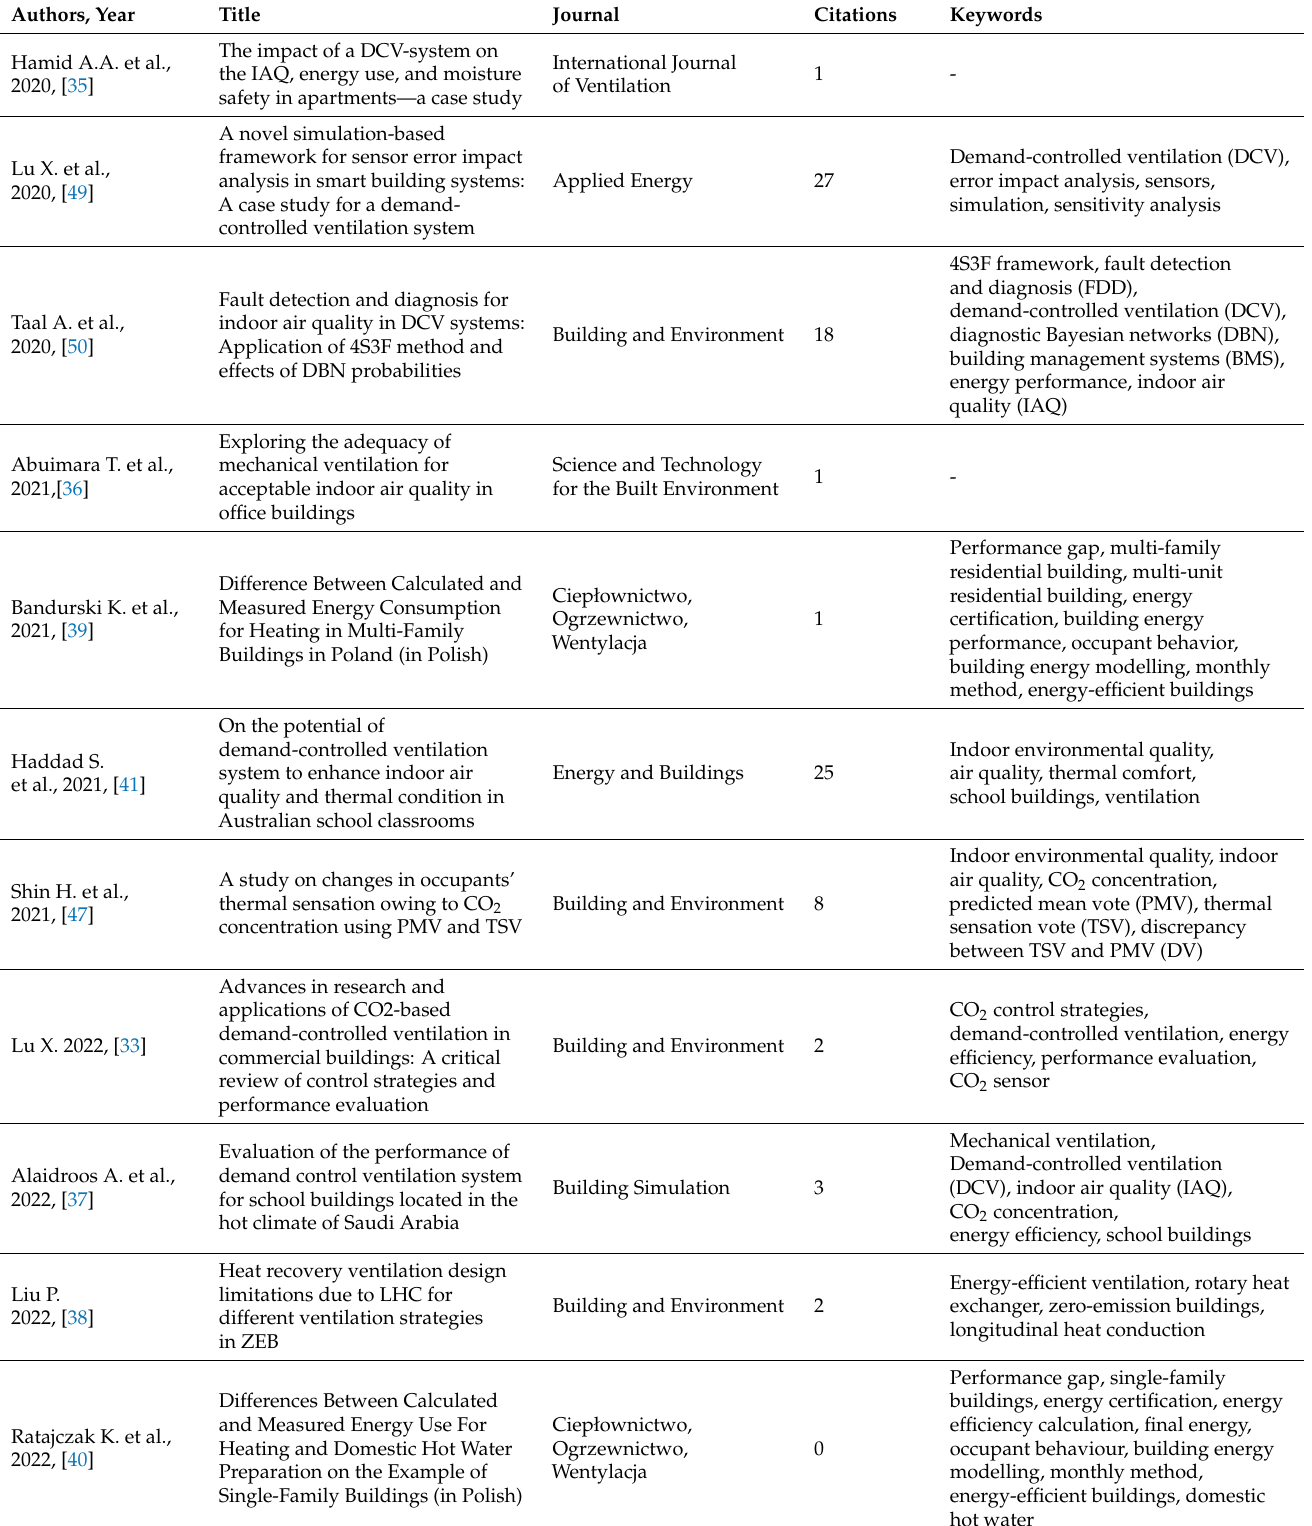
Table 2. Reviewed papers in